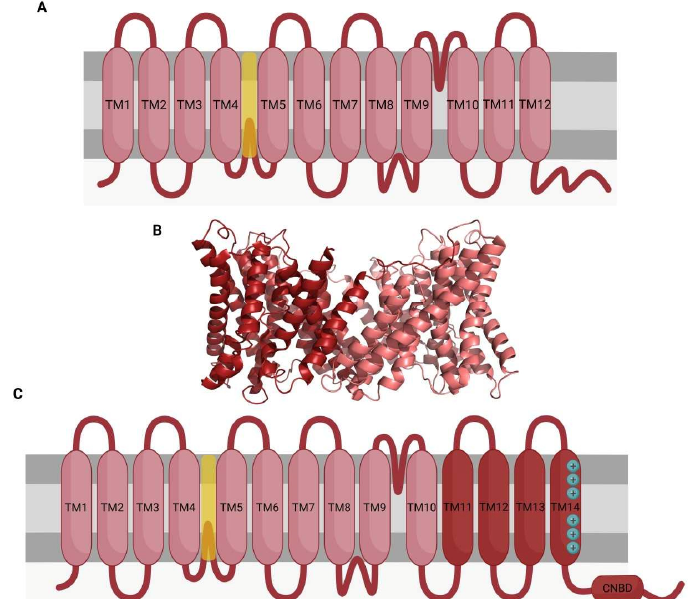
Figure 3. Structural characteristics of NHE channels. Sodium–proton exchangers from the SLC9 family of channels present slightly variable structures, with the sNHE channel presenting some characteristic features. ( A ) SLC9 channels generally present 12 transmembrane α -helices (TM1–12) connected through loops. An ion permeation pathway is formed between TM4 and TM5 (yellow). The C-terminal domain presents multiples sites of interaction with other proteins. ( B ) Quaternary conformation of SLC9 channels, which tend to form dimers, acquire a more stable conformation. The structure presented in this figure corresponds to the SLC9A1 channel (PDB reference 7DSW). ( C ) The sNHE channel structure is different from other NHE channels, mainly for TM11–14. This domain resembles the voltage-sensing domain of other channels. TM14 has a high number of basic residues, which corresponds to the voltage-sensing region (blue, +). The C-terminal region contains, among the sites of interaction with other molecules, a cyclic nucleotide ‐ binding domain (CNBD).